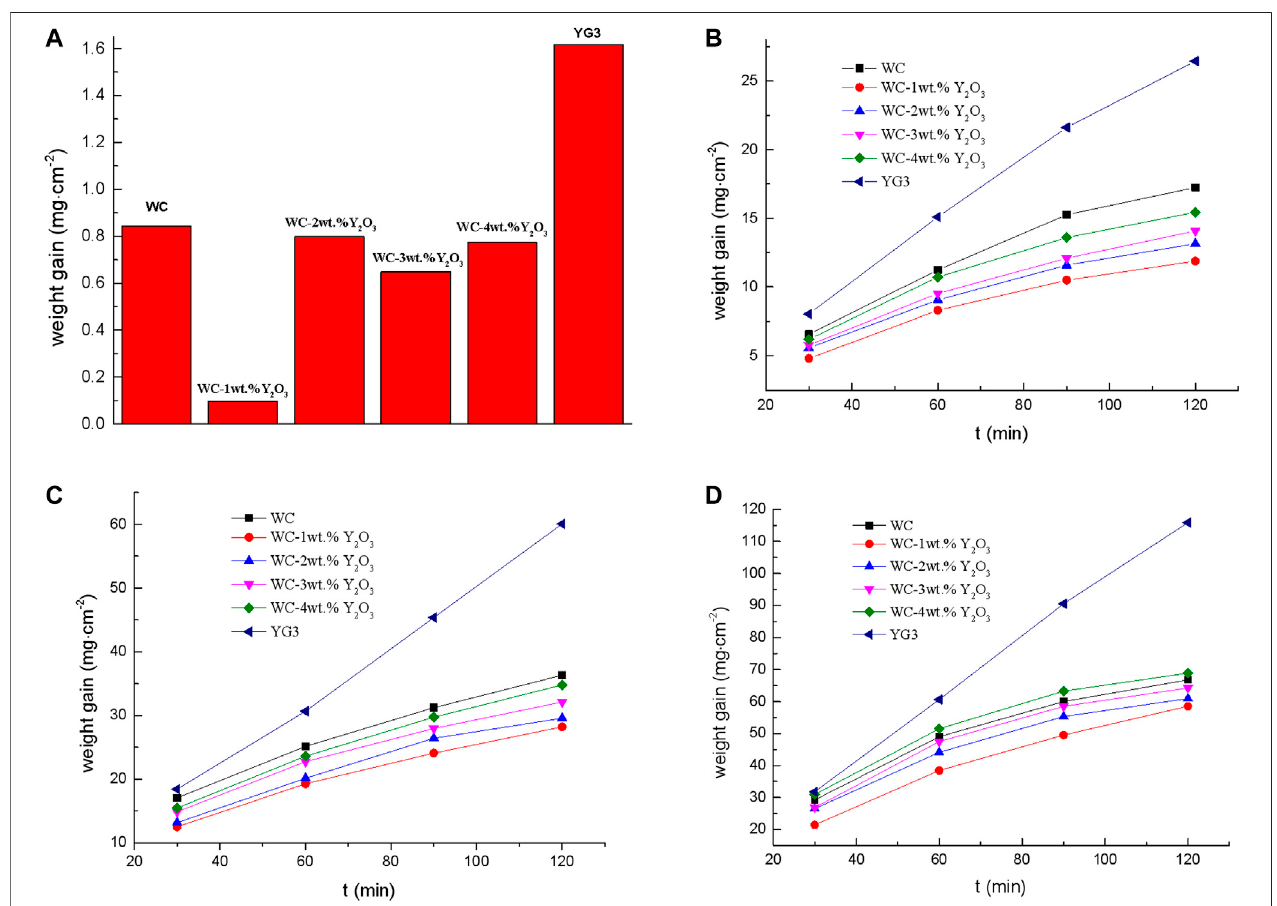
FIGURE1| OxidationweightgainofYG3cementedcarbideandbinderlesstungstencarbidewithdifferentcontentsofY 2 O 3 atdifferentoxidationtemperatures. (A) 600 ° C, 120 min. (B) 700 ° C. (C) 750 ° C. (D) 800 ° C.